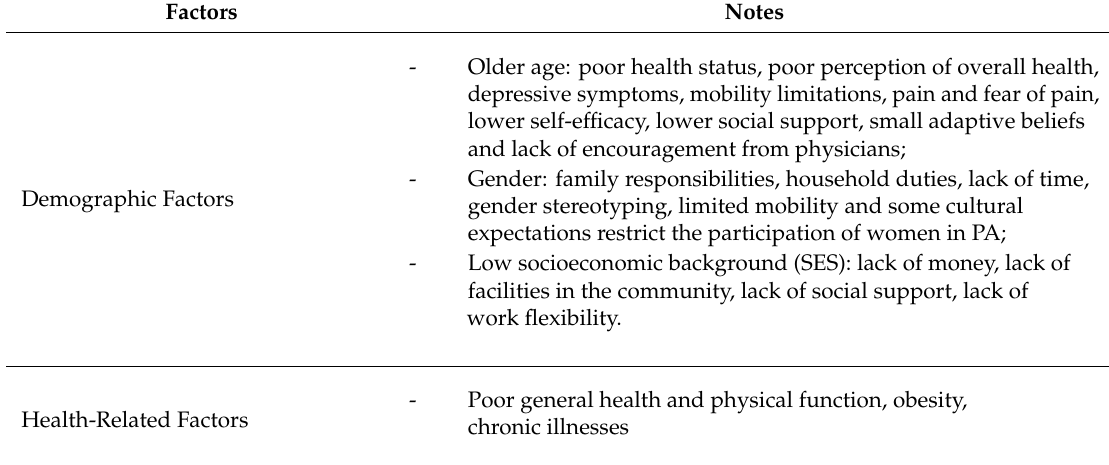
Table 1. Factors limiting undertaking physical